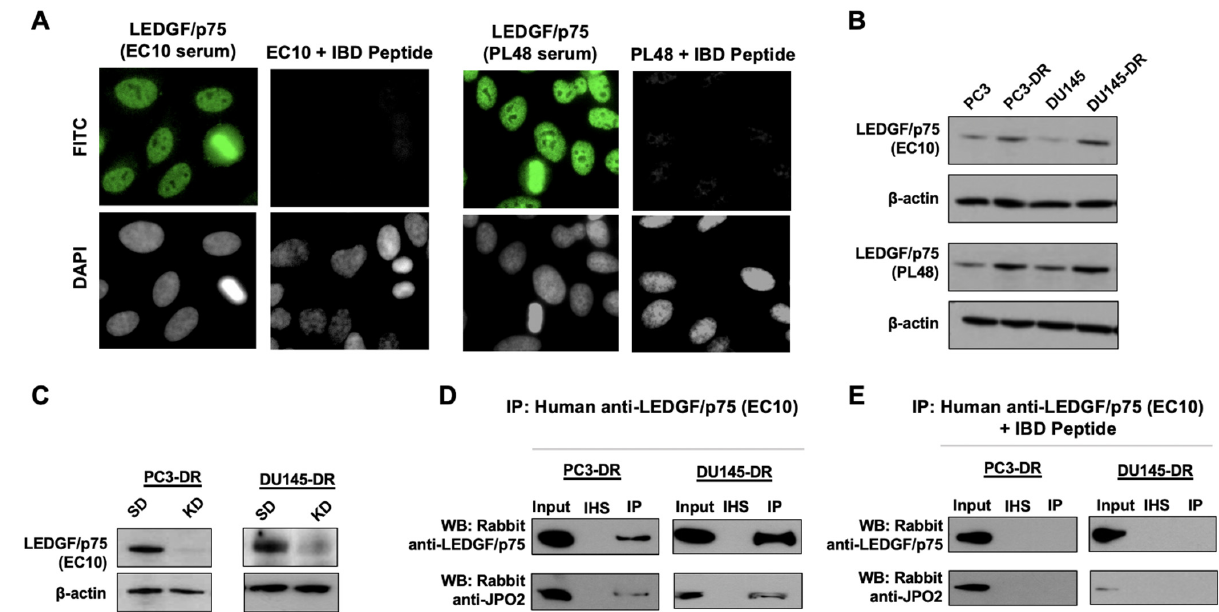
Figure 2. Validation of the specificity of human anti-LEDGF/p75 autoantibodies used in this study. ( A ) Representative human monospecific (only fluorescence pattern detected) anti-LEDGF/p75 sera (EC10 and PL48) displaying the character- istic dense fine speckled (DFS) nuclear pattern of high titer anti-LEDGF/p75 autoantibodies, also known as anti-DFS or anti-DFS70 autoantibodies (FITC), in HEp-2 antinuclear antibody (ANA) test slides. Pre-adsorption of the two human anti-LEDGF/p75 sera with the autoepitope-containing IBD peptide (LEDGF/p75 residues 347–429) abolished their immu- noreactivity in HEp-2 ANA test slides. ( B ) Immunoblots showing immunoreactivity of the selected anti-LEDGF/p75 sera against a 75 kD protein band in whole cell lysates of both parental and DTX-resistant PC3 and DU145 cell lines, with noticeable increased expression of the protein in the resistant cells. ( C ) Immunoblots showing the reactivity of representa- tive human serum EC10 against LEDGF/p75 in whole lysates from PC3-DR and DU145-DR cells, with siRNA-mediated LEDGF/p75 knockdown (KD) compared to scrambled duplex control (SD). Note the loss of serum immunoreactivity against the 75 kD protein band in cells with LEDGFp75 knockdown. Beta-actin was used as loading control in panels B and C. ( D ) Immunoprecipitation of endogenous LEDGF/p75 from PC3-DR and DU145-DR cells using representative anti- LEDGF/p75 human serum EC10. A well-characterized LEDGF/p75 interacting partner, JPO2, was used as a positive control to initially monitor and validate the capacity of monospecific anti-LEDGF/p75 sera to immunoprecipitate its IBD-interacting proteins. Irrelevant normal human serum (NHS) was used as negative control. ( E ) Pre-adsorption of anti-LEDGFp75 human EC10 serum with the autoepitope-containing IBD polypeptide abolished its ability to co-immunoprecipitate LEDGF/p75 and JPO2, again confirming the specificity of the serum